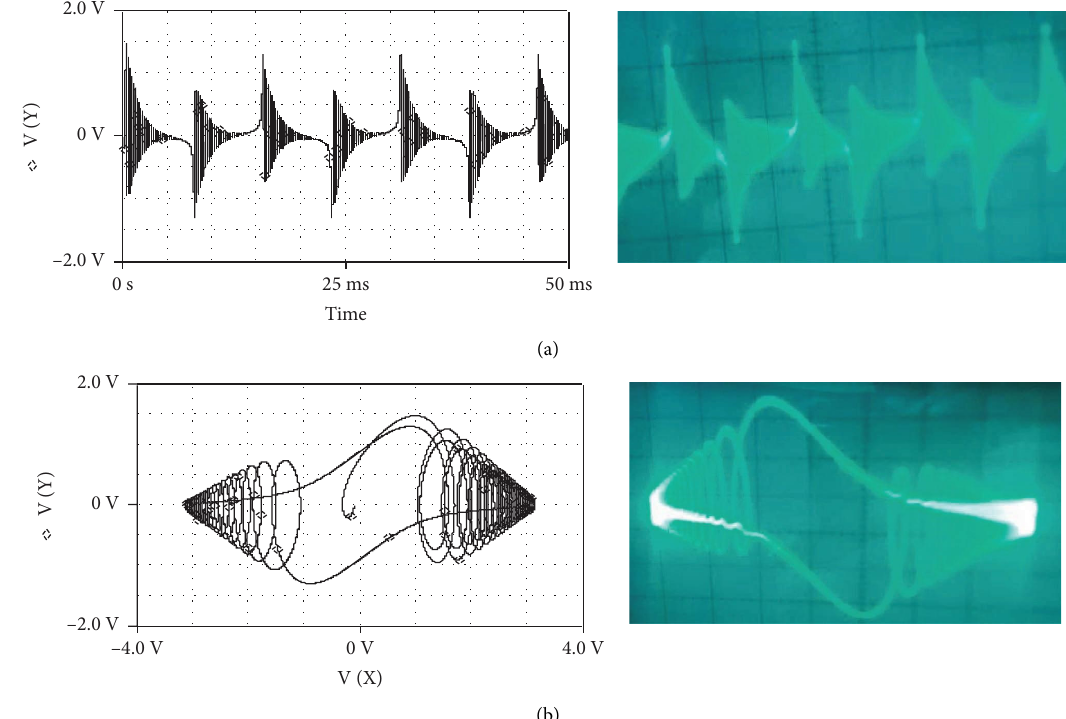
Figure 16: Numerical time domain and phase portraits (lhs) and the corresponding experimental results obtained with a dual trace oscilloscope in X − Y mode (rhs). In the experimental setup, the quantities V ( X ) and V ( Y ) are replaced by the capacitor voltages V C V x � 2 V /div and y � 5 V C 2 , respectively. Te scales are